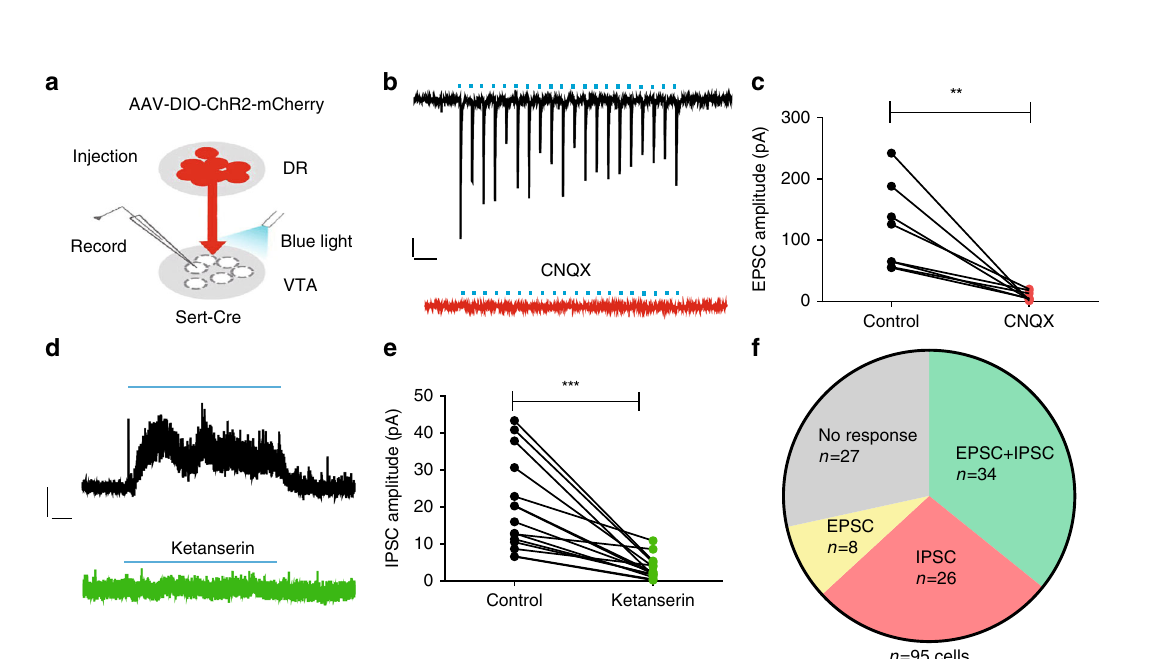
Fig. 2 Activating serotonergic terminals elicits glutamate and 5-HT release. a Schematic diagram showing whole-cell patch-clamp recordings from the VTA following the Cre-dependent expression of ChR2 in the DR of Sert-Cre mice. b Representative recording trace from a VTA neuron showing a fast EPSC evoked by the light stimulation (5 ms, 20 Hz) of DR axonal terminals (upper panel). Stimulation-induced EPSCs were abolished by the application of CNQX, an AMPA/kainate receptor antagonist (lower panel). Scale, 50 pA,100 ms. c Summary data showing that the amplitudes of light-evoked EPSCs were almost completely abolished by the application of CNQX; ( n = 8 cells from three mice; paired t -tests, t 7 = 4.172, P = 0.004). d Example of a voltage-clamp (0 mV) trace from optogenetic stimulation (30 s 20 Hz) of ChR2 + axonal terminals produced outward current that was largely blocked by ketanserin, a 5- HT 2A , and 5-HT 2C receptor antagonist. Scale, 20 pA, 4 s. e Summary data showing that the amplitudes of light-evoked IPSCs were signi fi cantly reduced by ketanserin ( n = 15 cells from four mice; paired t -tests, t 14 = 5.409, P = 0.000092). f Pie chart showing the distribution of response types in VTA neurons evoked by either single pulses (EPSC) or trains (IPSC) of optical stimulation of DR axons. EPSCs were measured at − 70 mV and IPSCs at 0 mV. Data are represented as mean ± SEM; ** P < 0.01, *** P < 0.001. Source data are provided as a Source Data fi